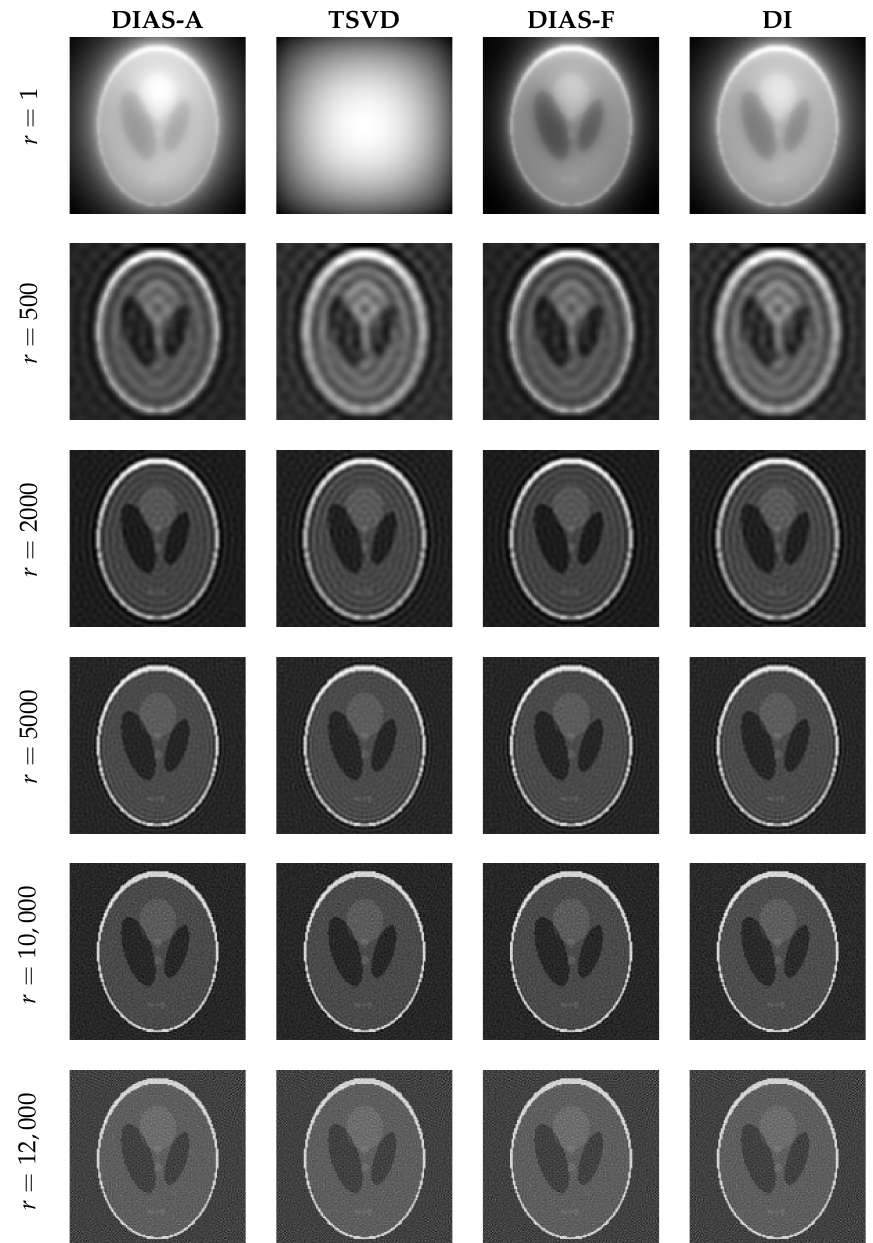
Figure 15. DIAS solutions for X-ray tomography problem with overregularization parameter α = 10 8 , noise level